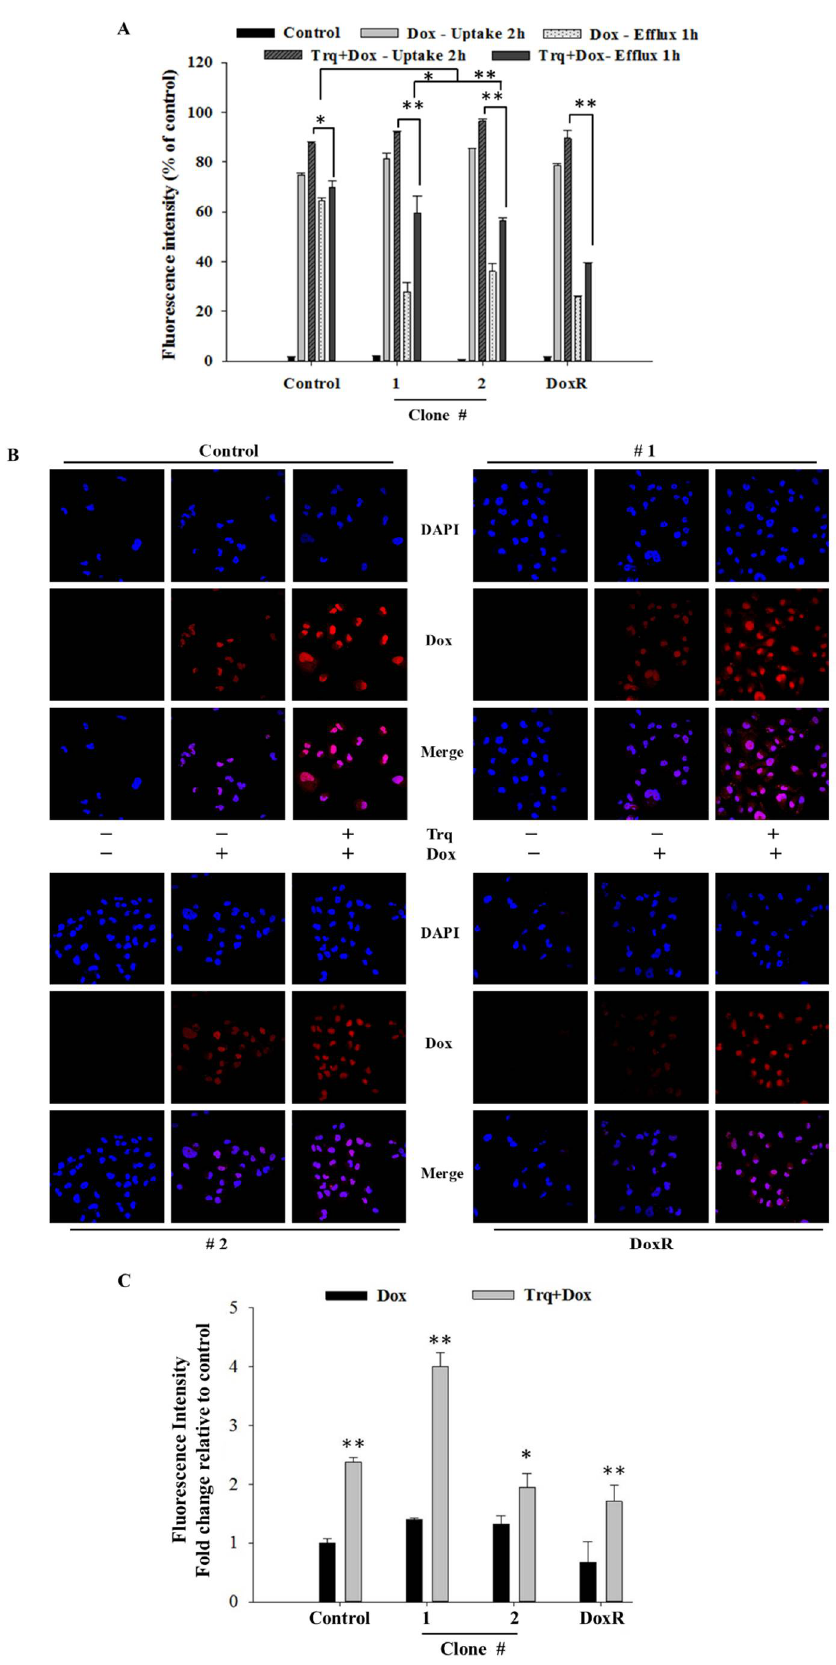
Figure 5. Quantitative and representative results of drug accumulation by flow cytometry and confocal microscopy. ( A ) Enhanced Dox (1 µM) accumulation was observed following 2 h of tariquidar (1.5 µM) pretreatment in DEHP-exposed